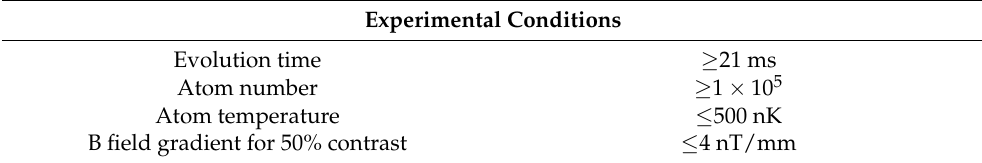
Table 1. Conditions required aiming for a magnetic field measurement one-shot resolution of 1